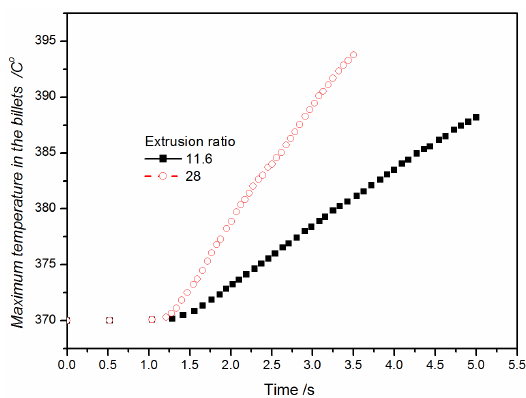
Figure 6. Comparison of maximum temperature in the extrusion rods with different extrusion ratios: 11.6 and 28.